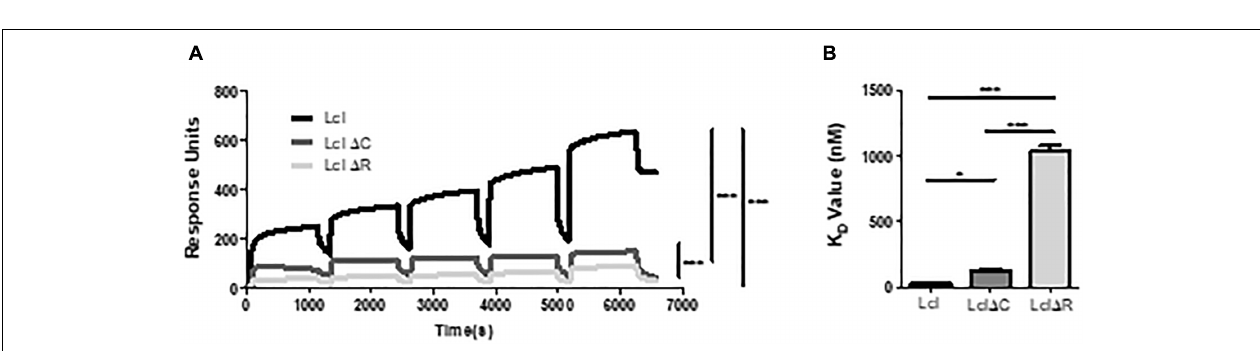
FIGURE 3 | Lcl forms supramolecular complexes composed of trimers. (A) Size exclusion chromatography profiles of purified-His tagged Lcl (A) , values are the averages of 3 separate determinations and the molecular weights of standard proteins was estimated from the standard curve based on elution polymers. (B,C) His-tagged purified Lcl, Lcl (cid:49) R, and Lcl (cid:49) C was incubated at 4 ◦ C or at 90 ◦ C for 10 min and analyzed by Native-gel electrophoresis and visualized by Coomassie staining (B) and on SDS-PAGE and visualized by Western blotting using anti-His antibodies following treatment with Laemli buffer and boiling (C) .